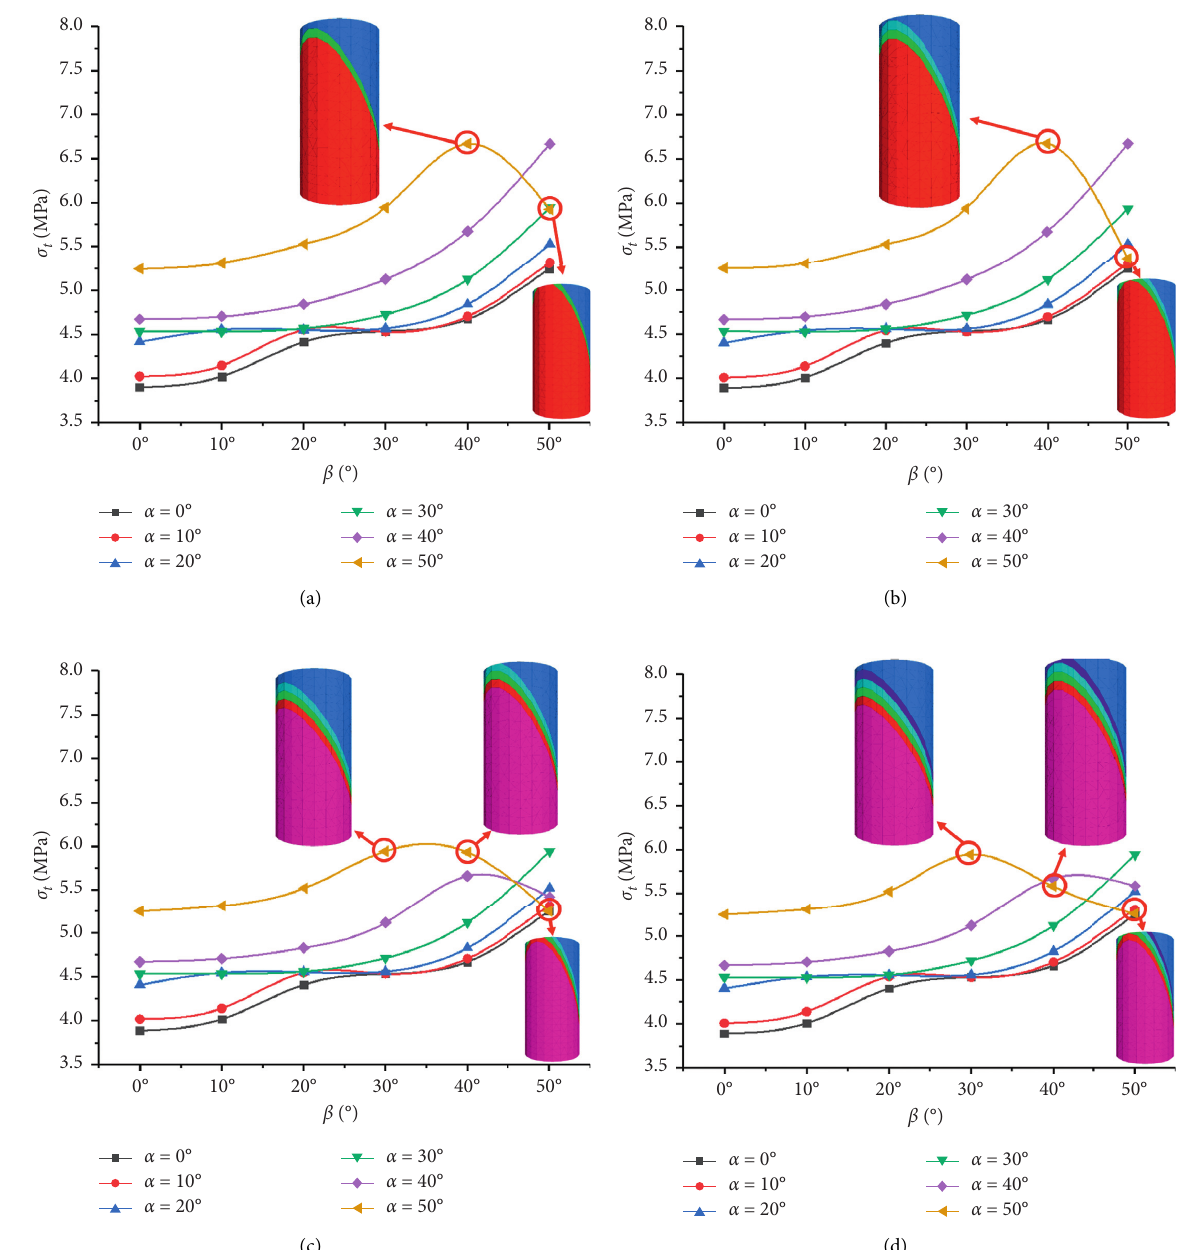
Figure 8: Variation curve of σ